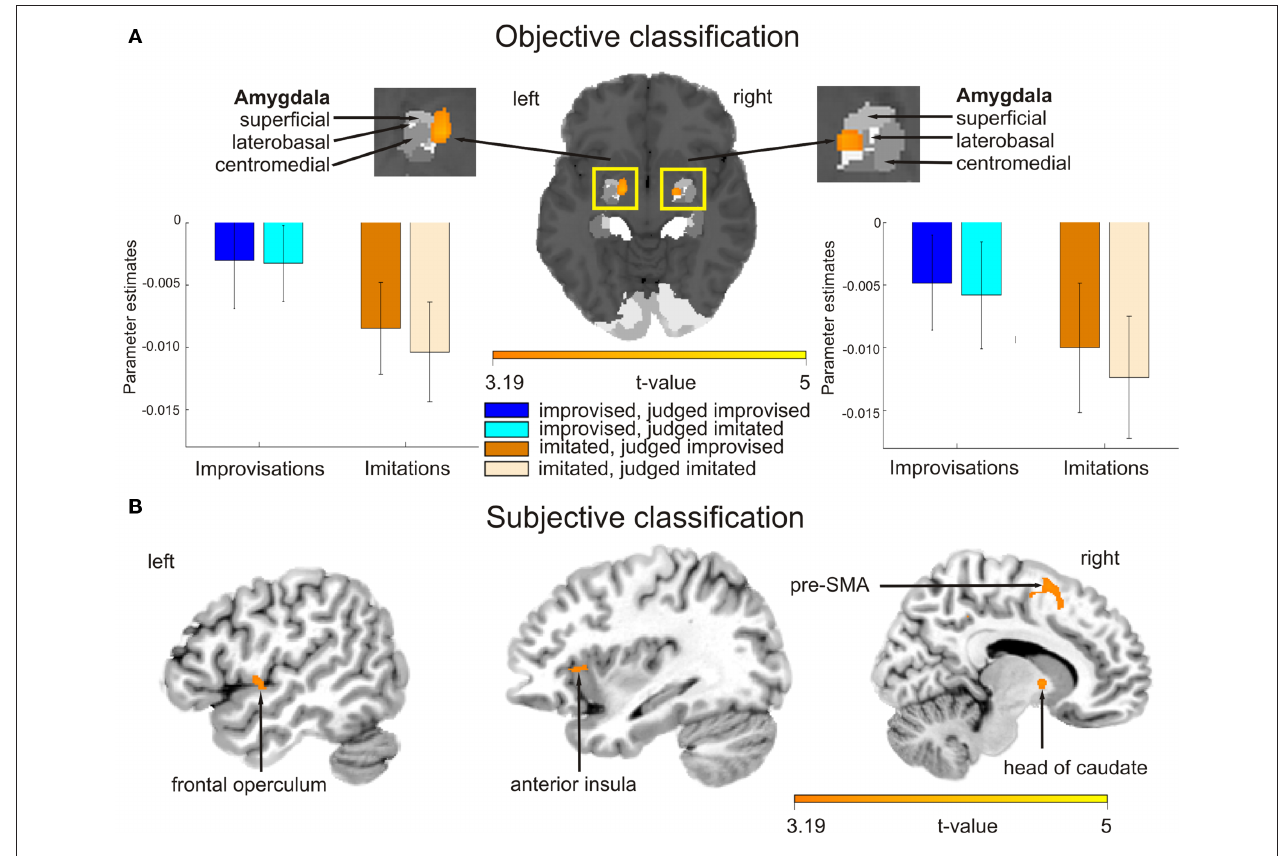
FIguRe 3 | Blood oxygen level dependent activation patterns based on the contrasts of interest superimposed on an MnI standard brain. (A) Contrast for the main effect based on the objective classification of stimuli (listening to improvised vs. imitated melodies). The activation map is overlaid on a probabilistic anatomical map based on histological analyses of 10 post-mortem human brains (Amunts et al., 2005; www.fz-juelich.de/ime/